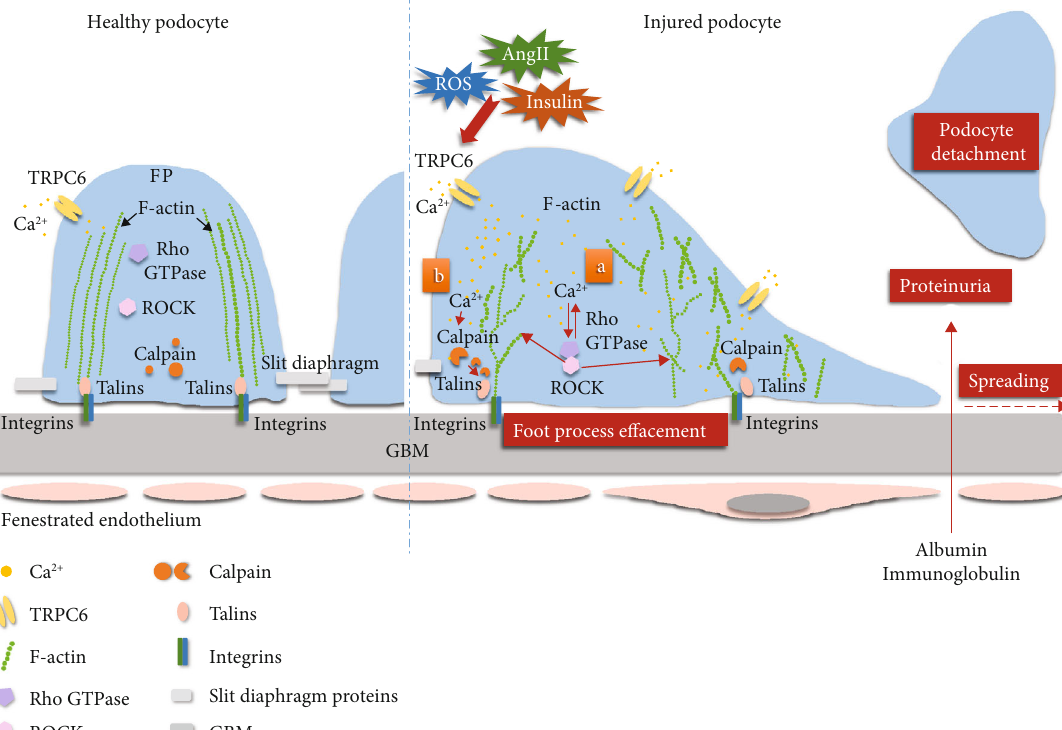
Figure 1: TRPC6 is involved in the rearrangement of podocyte actin cytoskeleton. In DKD, various stimulating factors lead to high expression of TRPC6 and a large amount of Ca 2+ in fl ux, causing podocyte hypertrophy and foot process e ff acement. By binding Rho GTPase family proteins to ROCK, F-actin becomes disordered, shortened, and branched (a), or talins are abnormally cleaved by activation of calpain (b), causes the destruction of podocyte focal adhesion complex structure, increased motility, and ultimately leads to foot processes e ff acement, detachment of podocytes, and proteinuria. Abbreviations: FP: foot process; TRPC6: transient receptor potential canonical channel 6; Rho GTPase: Rho guanosine triphosphatase (Rho A, Rac1, and Cdc42); ROCK: Rho-associated coiled-coil protein kinase; GBM: glomerular basement membrane; ROS: reactive oxygen species; Ang II: angiotensin